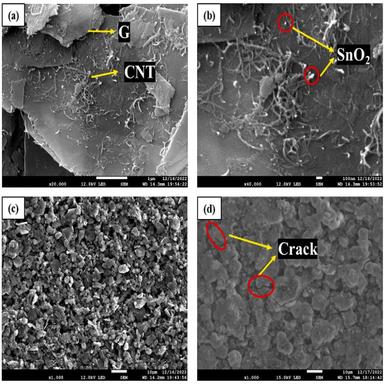
Morphology images of the (a, b) as-prepared composite at different magnifications, and the electrode surface (c) before and (d) after 8 charging and discharging processes at 100 mA g− 1 .